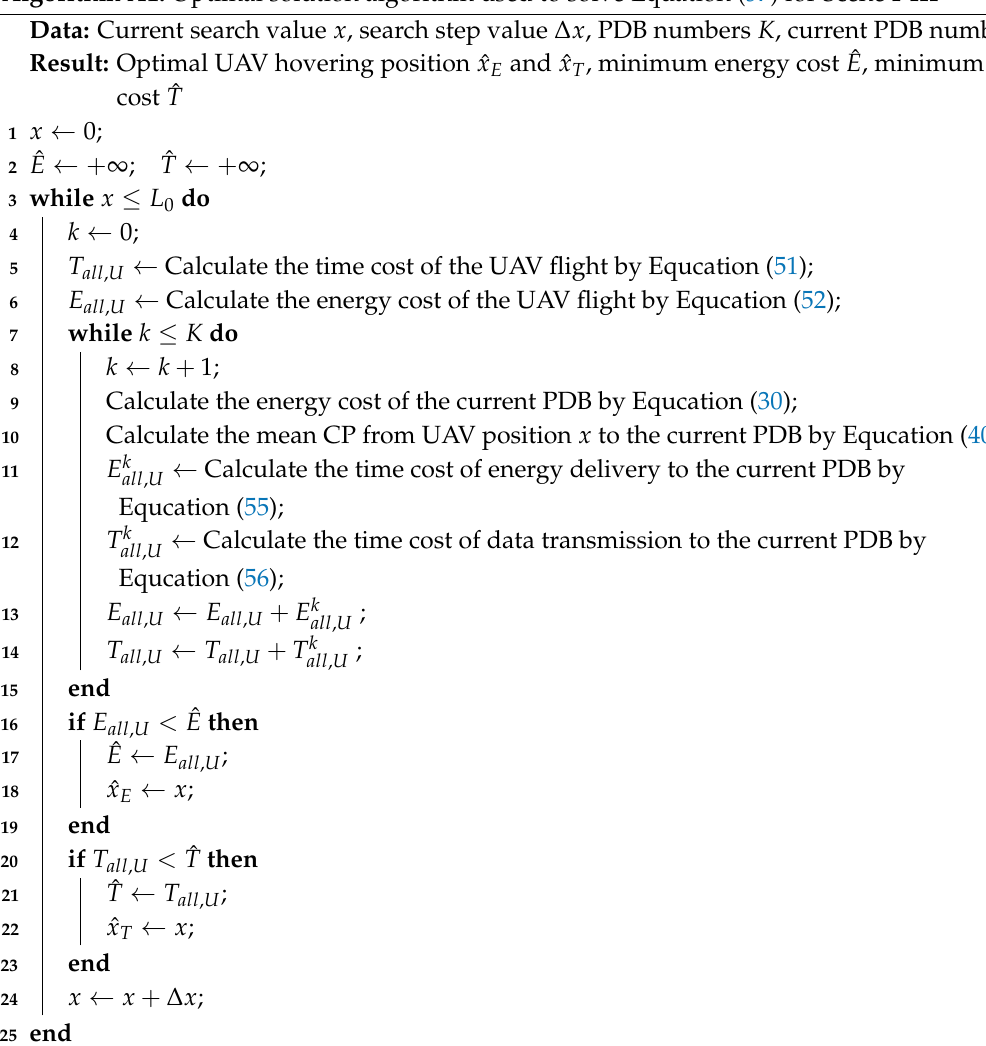
Algorithm A1: Optimal solution algorithm used to solve Equation (57) for Scene I -